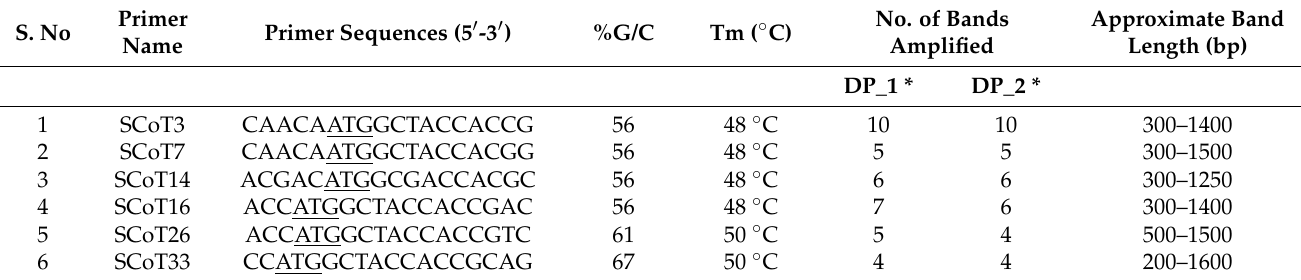
Table 7. List of SCoT primers, their sequences, %G/C, Tm, number of bands and their approximate band length (bp) obtained in micropropagated plantlets of D.purpurea.